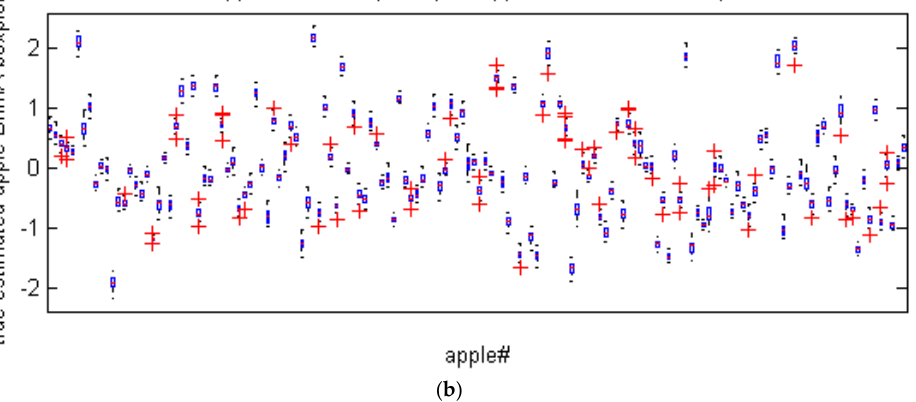
Figure 7. Box diagrams of the difference between the true and the predicted values of the BrimA of Gala apples in 500 iterations. ( a ) ANN-ICA method, ( b ) PLSR